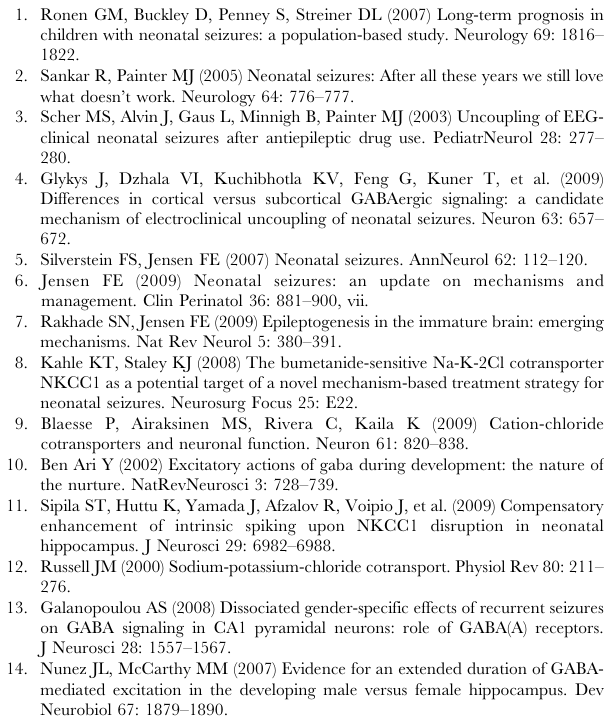
Table S1 Serum and brain bumetanide levels, and brain:serum ratio in littermate controls. Dose =bumeta- nide dosage. Time= min after bumetanide injection. n =number of rats. Concentrations (Conc.) are expressed as mean 6 SEM. Table S2 Serum and brain bumetanide levels, and brain:serum ratio after hypoxic seizures. Dose =bumeta- nide dosage. Time= min after bumetanide injection. n =number of rats. Concentrations (Conc.) are expressed as mean 6